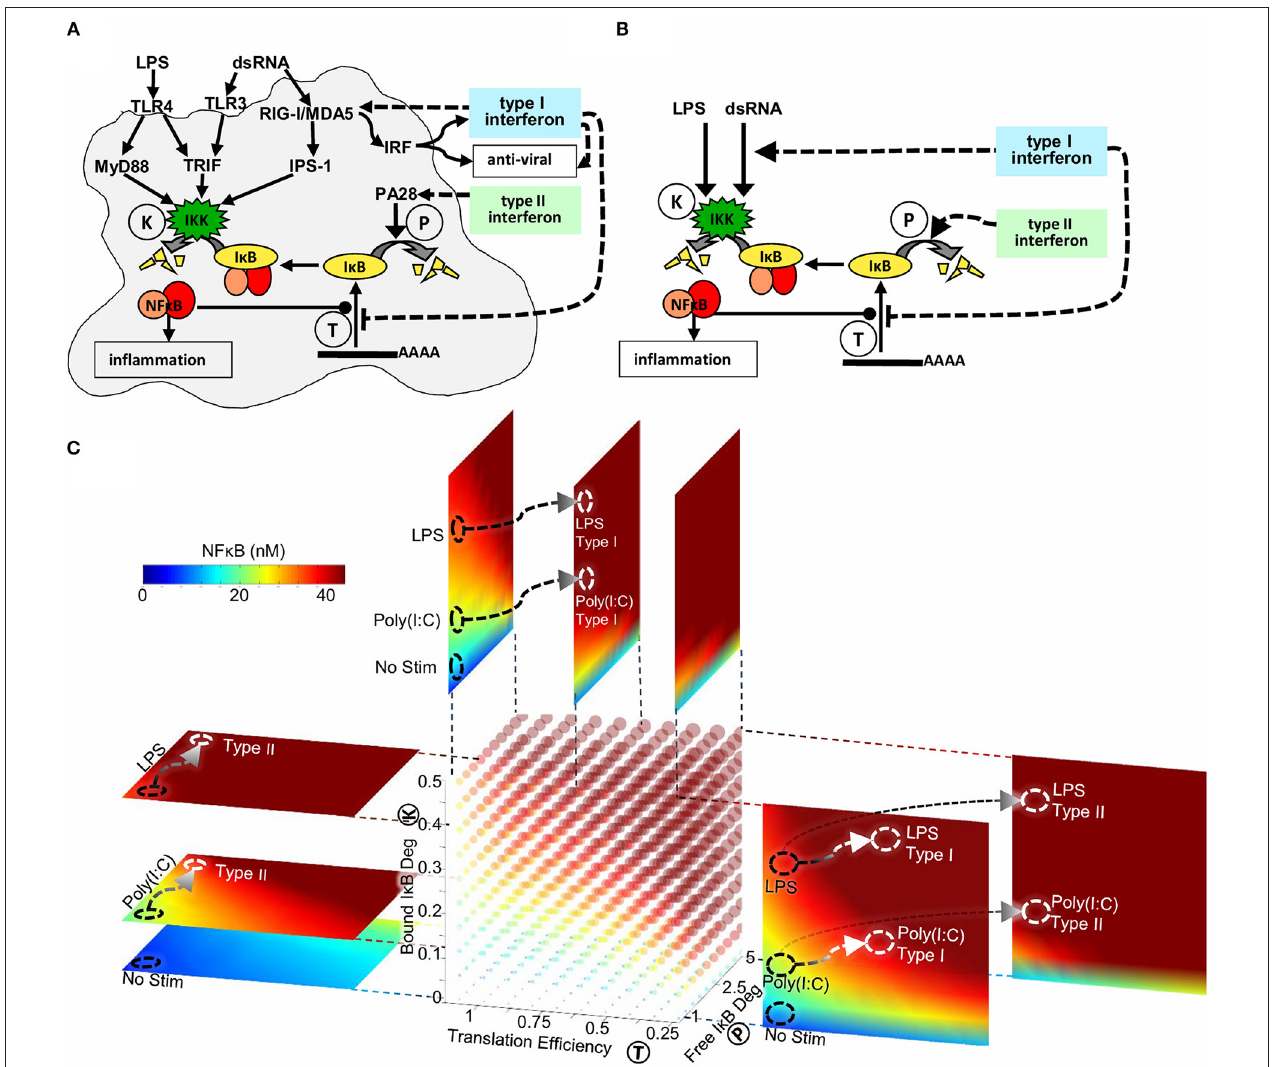
FIGURE 6 | The mechanisms underlying interferon signaling crosstalk on NF κ B. (A) Type I interferons reduce I κ B expression and increase IKK activity through RIG-I and IPS-1. Type II interferons increase free I κ B degradation through a PA28-dependent process. (B) Type I interferons reduce translation of I κ B α and increase the expression of the cytosolic viral sensor to allow for enhanced IKK mediated degradation of NF κ B-bound I κ B α . Type II interferon increases the degradation rate of free I κ B α . All mechanisms potentiate the NF κ B response to weak signals emanating from viral PAMP sensors, but have little effect on bacterial-MyD88-mediated responses. (C) Three-dimensional heatmap of nuclear NF κ B concentrations as a function of three biochemical reactions: IKK activity (reaction K), I κ B translation efficiency (reaction T) and free I κ B degradation (reaction P). The point in this parameter space reached following Poly(I:C) and LPS stimulus is marked with black circles. Signaling crosstalk by Type I and Type II interferons produce distinct trajectories through this three-dimensional parameter space (marked with white arrows to white circles).